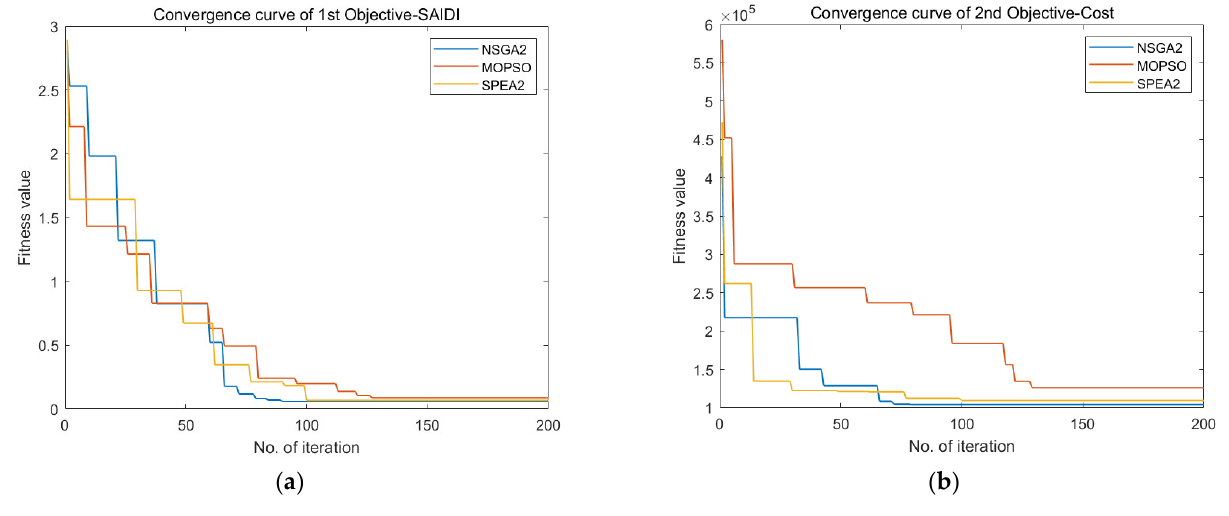
Figure 7. Convergence curve of: ( a ) SAIDI; ( b ) cost.